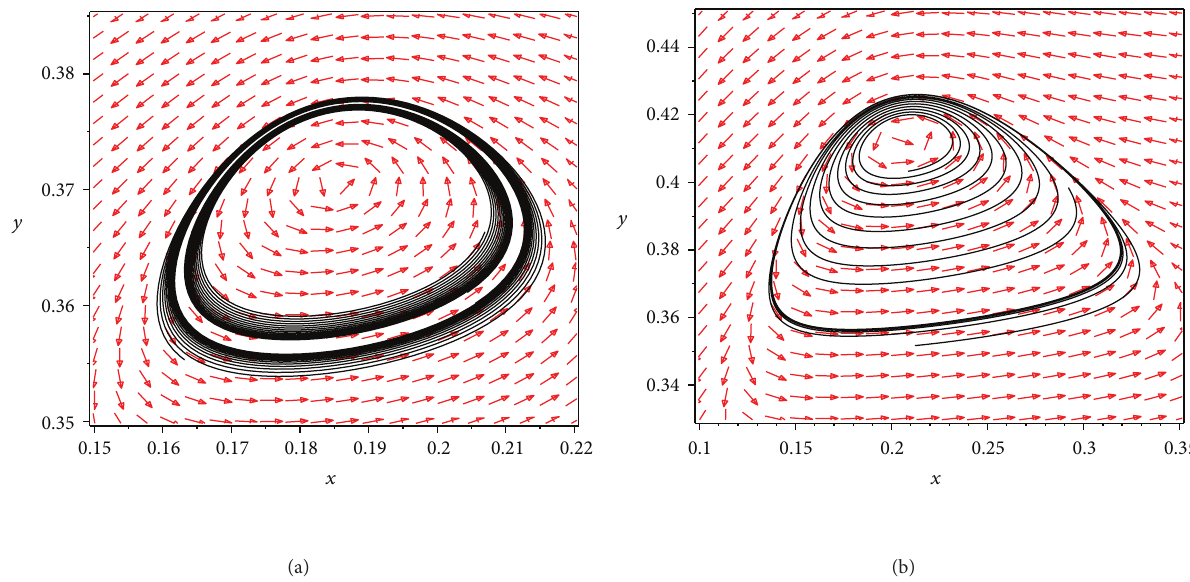
̃𝛿 ≈ ≈ 0.0000391 < 𝛿 = 0.002919 < ̃𝛿 ≈ 1